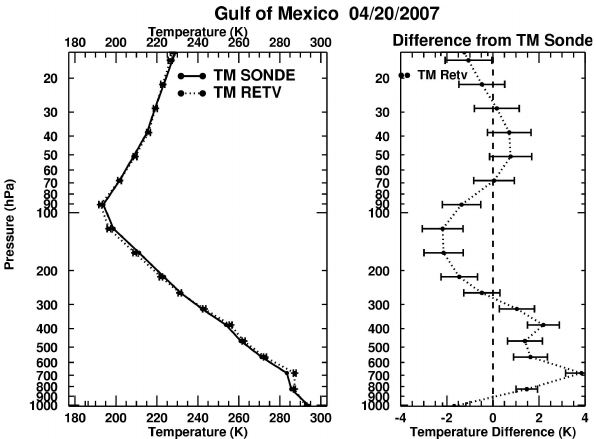
Fig. 7. Comparison plot of the sonde (a priori) and the retrieved temperature profiles for the ocean case over the Gulf of